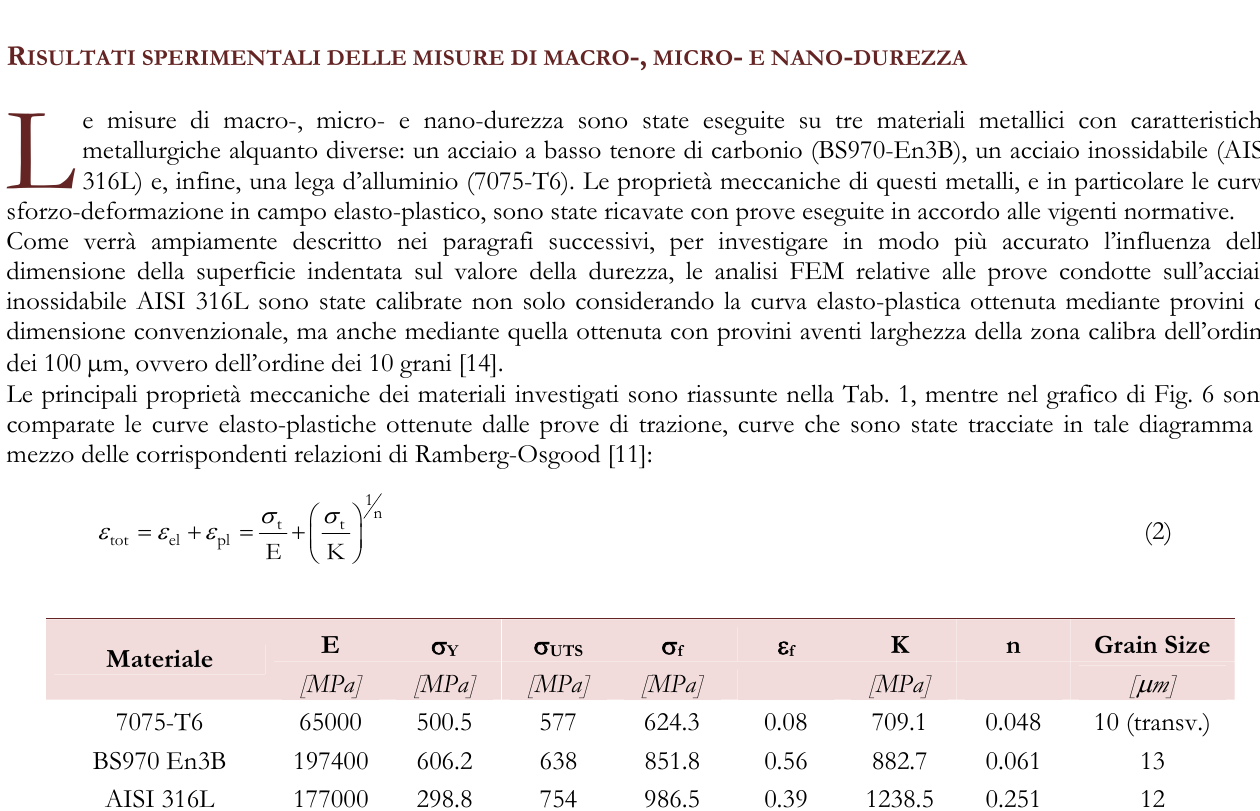
Figura 5: Rampa di carico e scarico utilizzata per simulare una prova Vickers standard. Figure 5: Loading and unloading curve used to simulate the Vickers test.